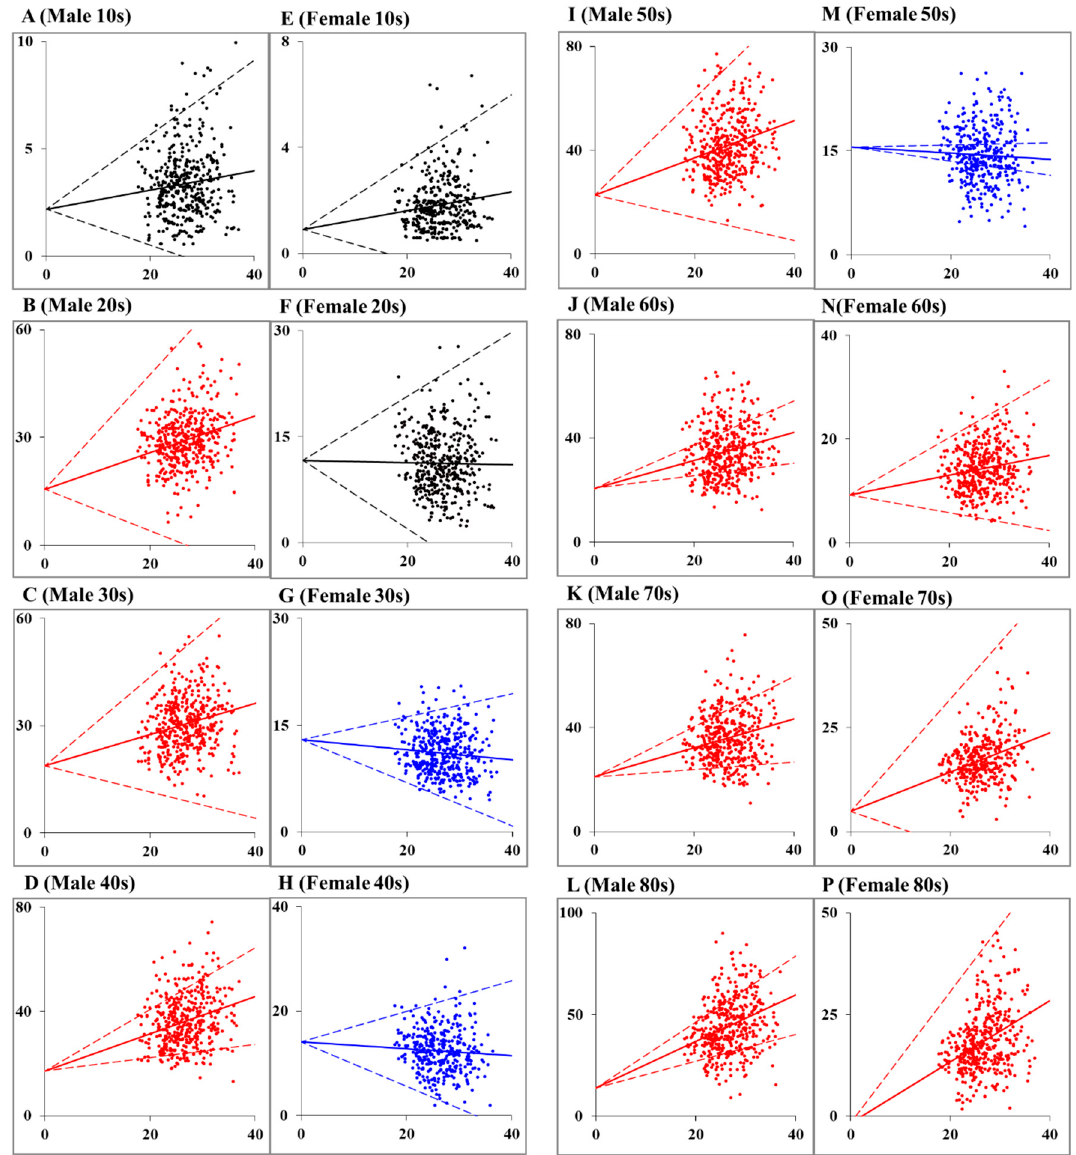
Figure 3. Correlation between dual-income rate and suicide mortalities of Male and Female disaggregated by ages using random-effect analysis of hierarchal linear regression model. Ordinates and abscissas indicate suicide mortality (per 100,000 population) and dual-income household rate (%), respectively. Blue, red and black lines indicate significant decreasing, increasing and no effect on suicide mortalities, respectively. Full and dotted lines indicate estimated random effects regression and standard deviations by hierarchal linear regression model, respectively.